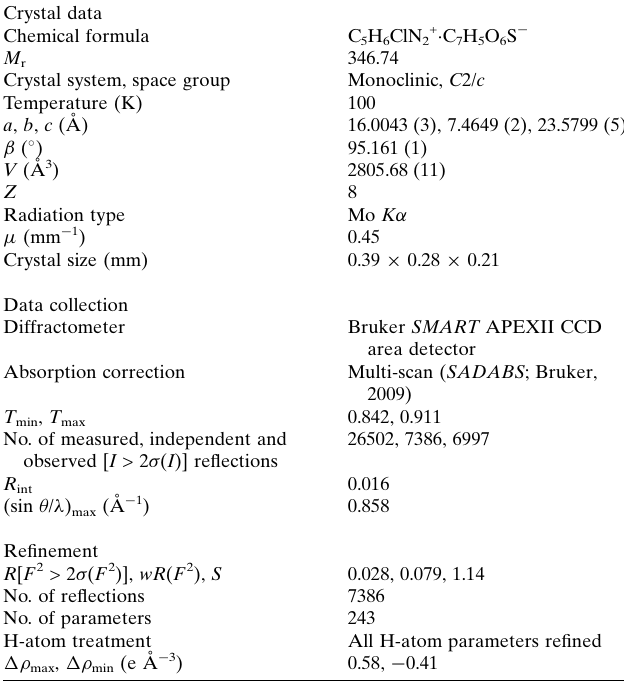
Table 2 Experimental details. Crystal data Chemical formula